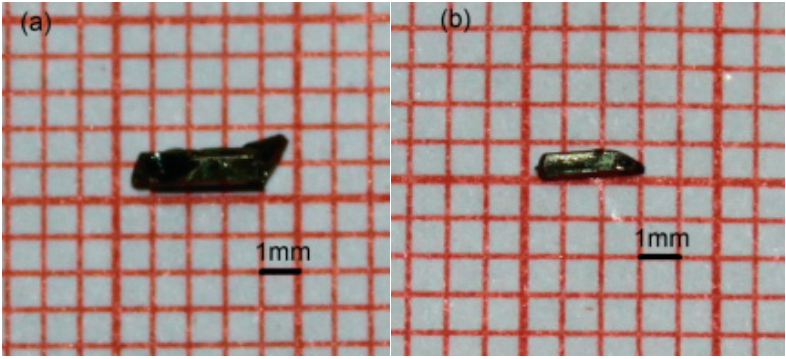
Figure 9. Single crystals of TPNS ( a ) and TPTMS ( b ).